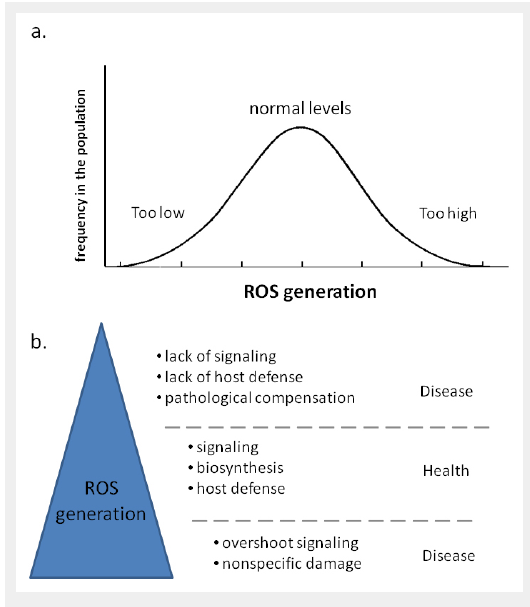
Variations of ROS generation. (a) Conceptual representation of genetically-determined ROS generation in the human population. Globally, there are significant variations of ROS generation. Note, however, that there is also regulation of ROS generation by epigenetics and external influences. (b) At moderate levels, NOX have crucial roles in health through mechanisms including signaling, biosynthetic processes, and host defence. When ROS levels are too low, the condition may result in decreased antimicrobial defence (e.g. chronic granulomatous disease), hypothyroidosis, low blood pressure or loss of otoconia. When levels are too high, there is increased cardiovascular disease, neurological disorders, cancers, and chronic